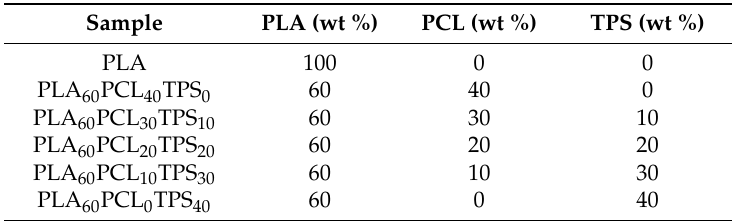
Composition and coding of the polylactide (PLA), poly( ε -caprolactone) (PCL), and thermoplastic starch (TPS)